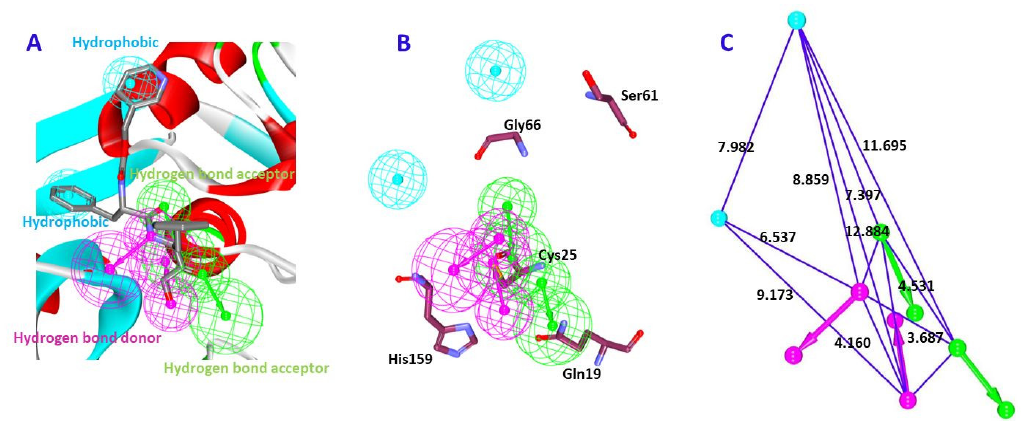
Figure 3. Structure-based pharmacophore generation. ( A ) Pharmacophore model displaying different features against the bound inhibitor. ( B ) Pharm 2 representing key residues. ( C ) Interfeature distance displayed by pharm 2.